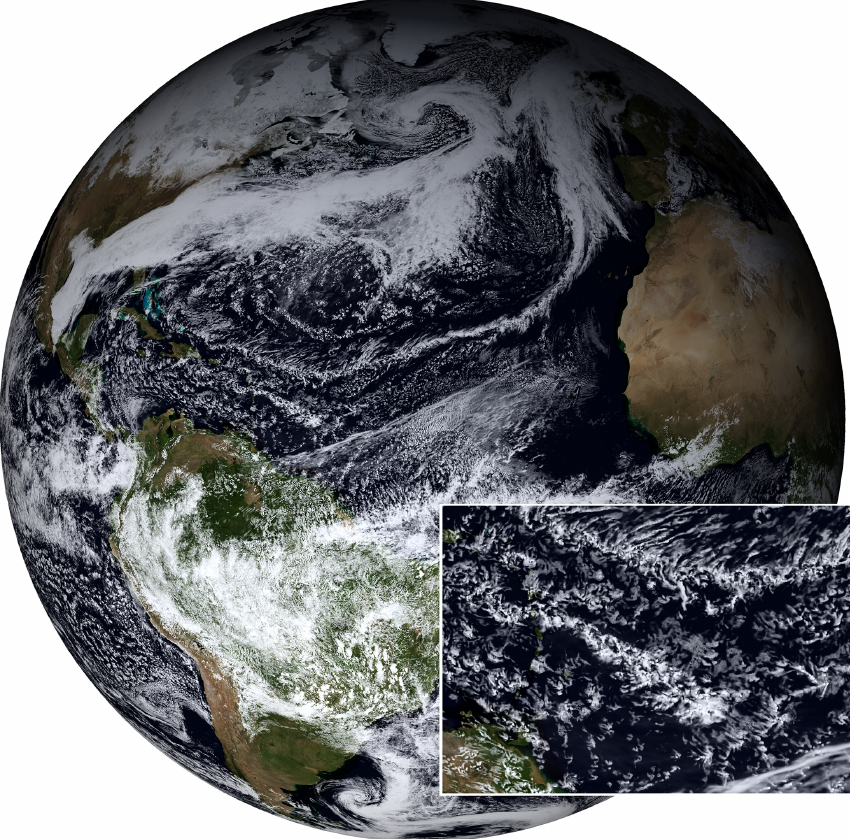
Figure 19. Global 2.5km mesh simulations performed by ICON as part of DYAMOND-Winter for the EUREC 4 A period. The snapshot, with a magnification over the study region to show the degree of detail in the simulations, was taken from 2 February of a simulation initialized on 20 January and allowed to freely evolve